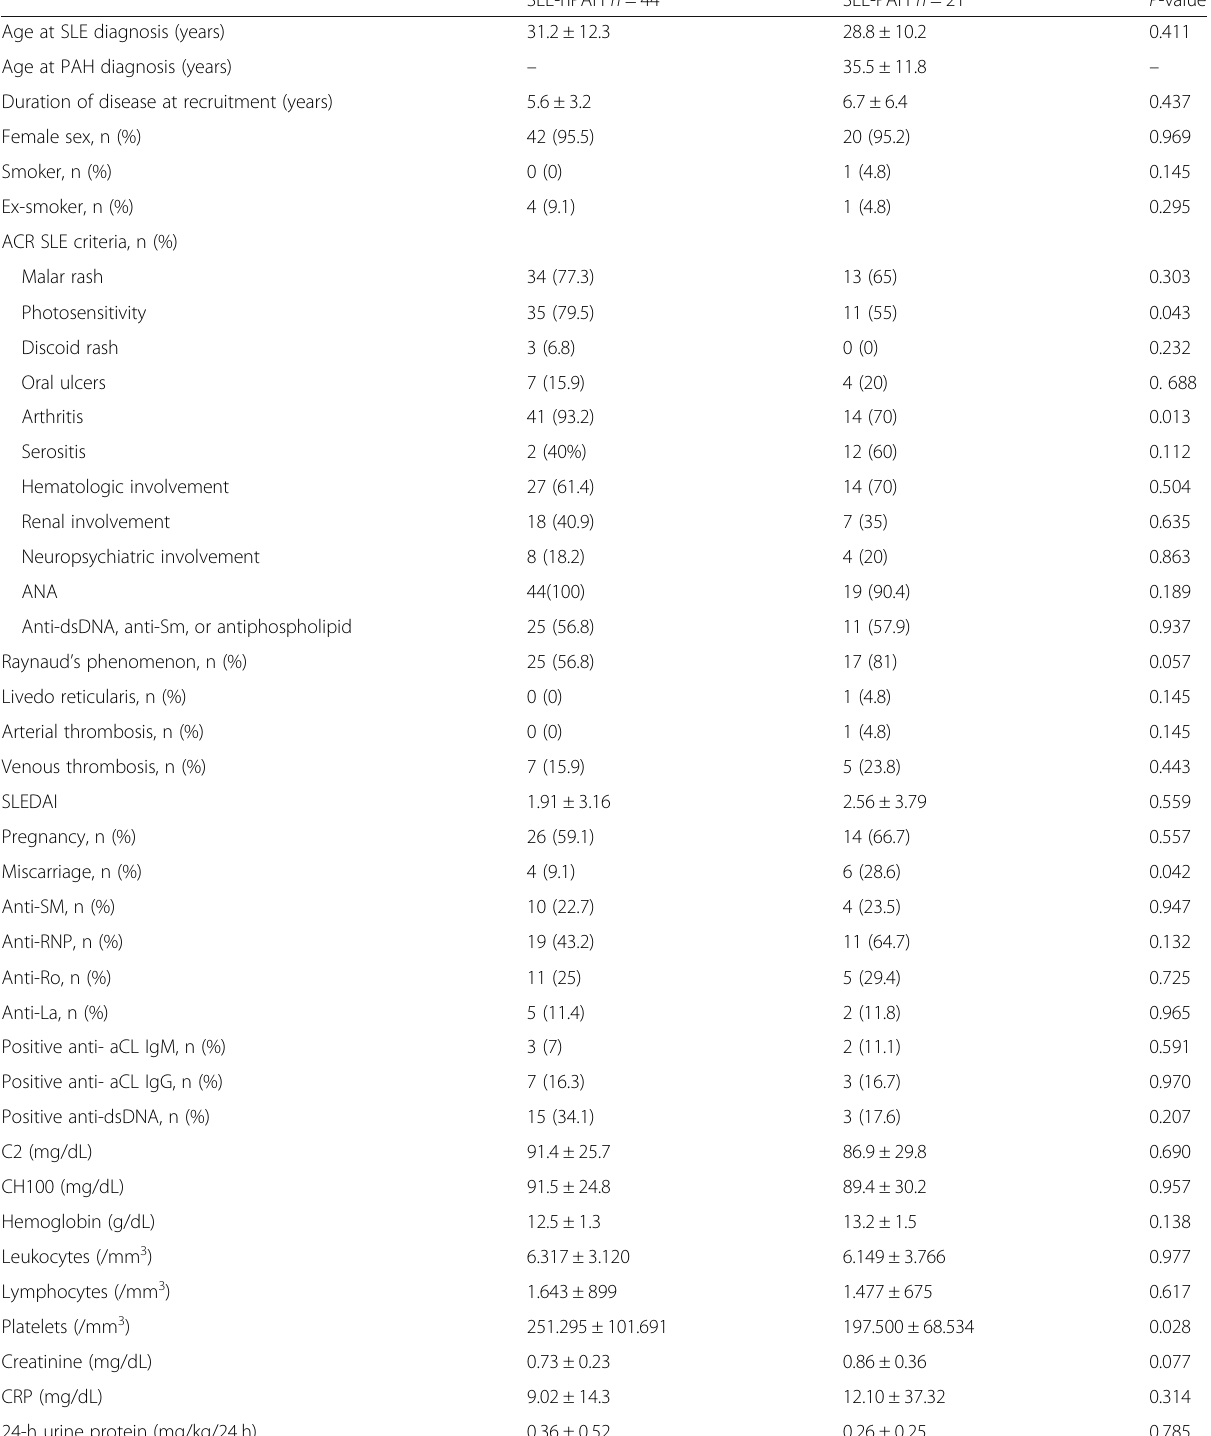
Table 1 Clinical and demographic characteristics of patients with SLE associated with PAH (SLE-PAH) or not associated with PAH